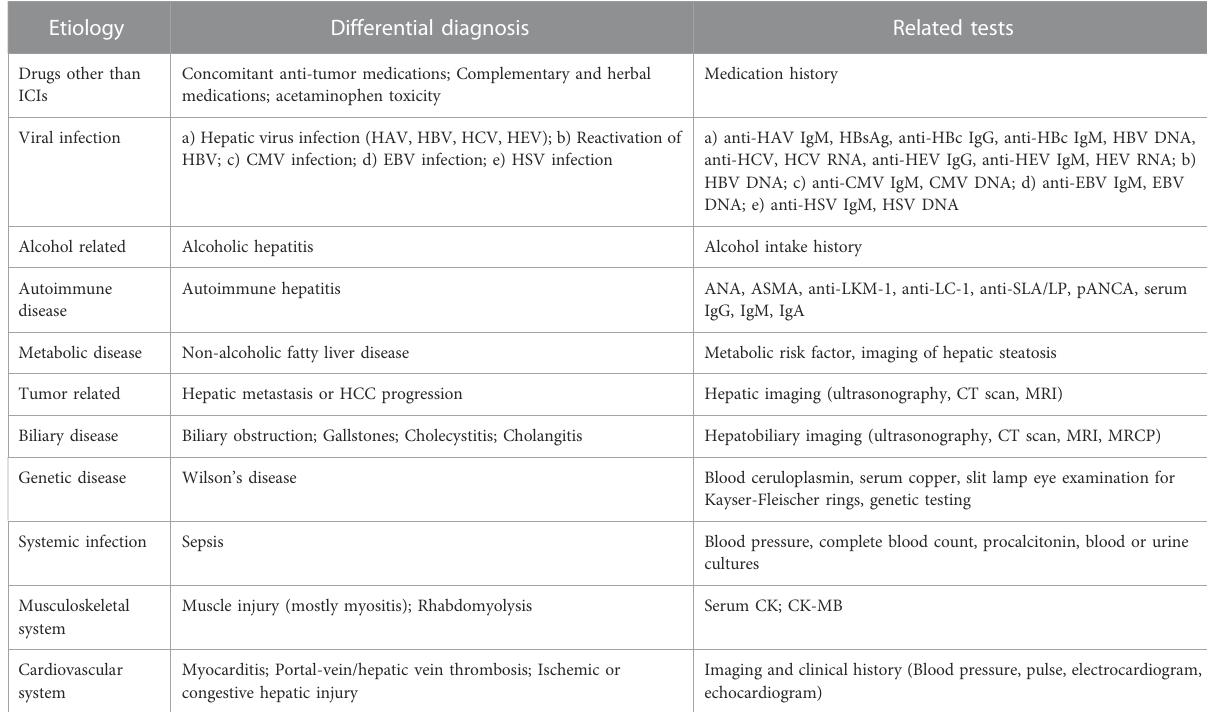
TABLE 3 Differential diagnosis and recommended tests in immune-mediated hepatitis